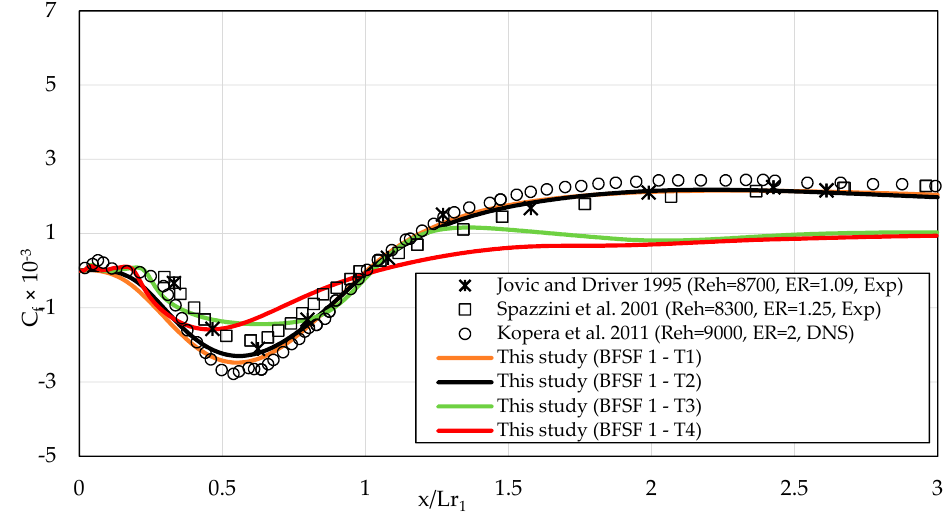
Figure 11. Longitudinal distribution of C f at the bottom wall downstream of the step [15,30,65]. The results were compared with the available numerical result [30] at Re h = 9000 and ER = 2. The distribution of skin friction in the standard k- ε and RNG k- ε turbulence models was consistent with that of the literature experimental data [15,65] and numerical results [30]. The average error was lower than 17.5%. The most accurate model in predicting skin friction coefficient was the standard k- ε , followed by RNG k- ε , standard k- ω , and SST k- ω . The standard k- ω , and SST k- ω were not good enough to capture the skin friction coefficient near the bottom wall.